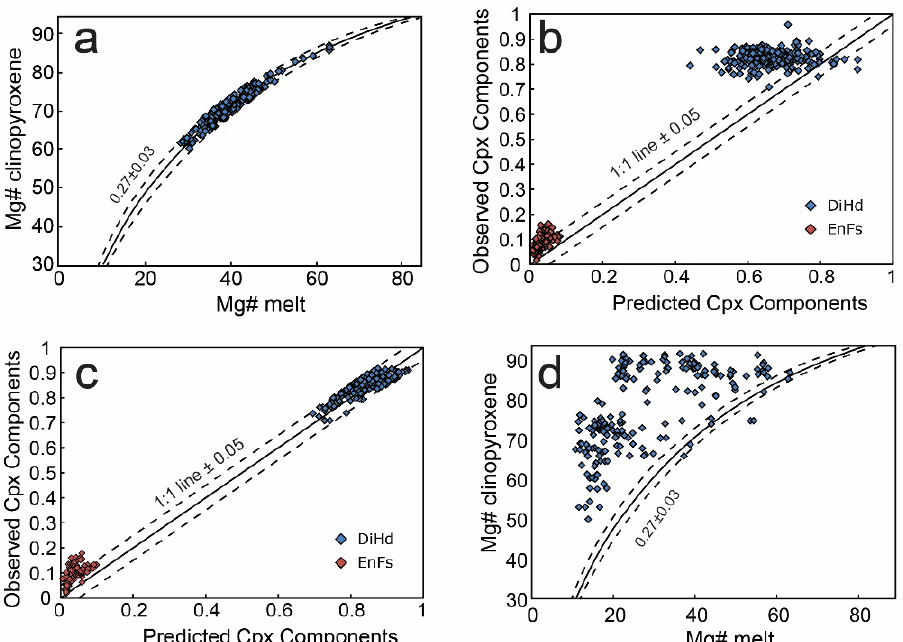
Figure 12. Comparison between the clinopyroxene-melt pairs resulted in equilibrium through test 1 and those resulted in equilibrium through test 2. The clinopyroxene-melt couples resulting in equilibrium through the Fe-Mg exchange coefficient ( a ) do not result in equilibrium comparing the measured and predicted DiHd component ( b ); the clinopyroxene-melt couples resulting in equilibrium through the comparison between measured and predicted DiHd component ( c ) do not result in equilibrium according to the Fe-Mg exchange coefficient ( d ).